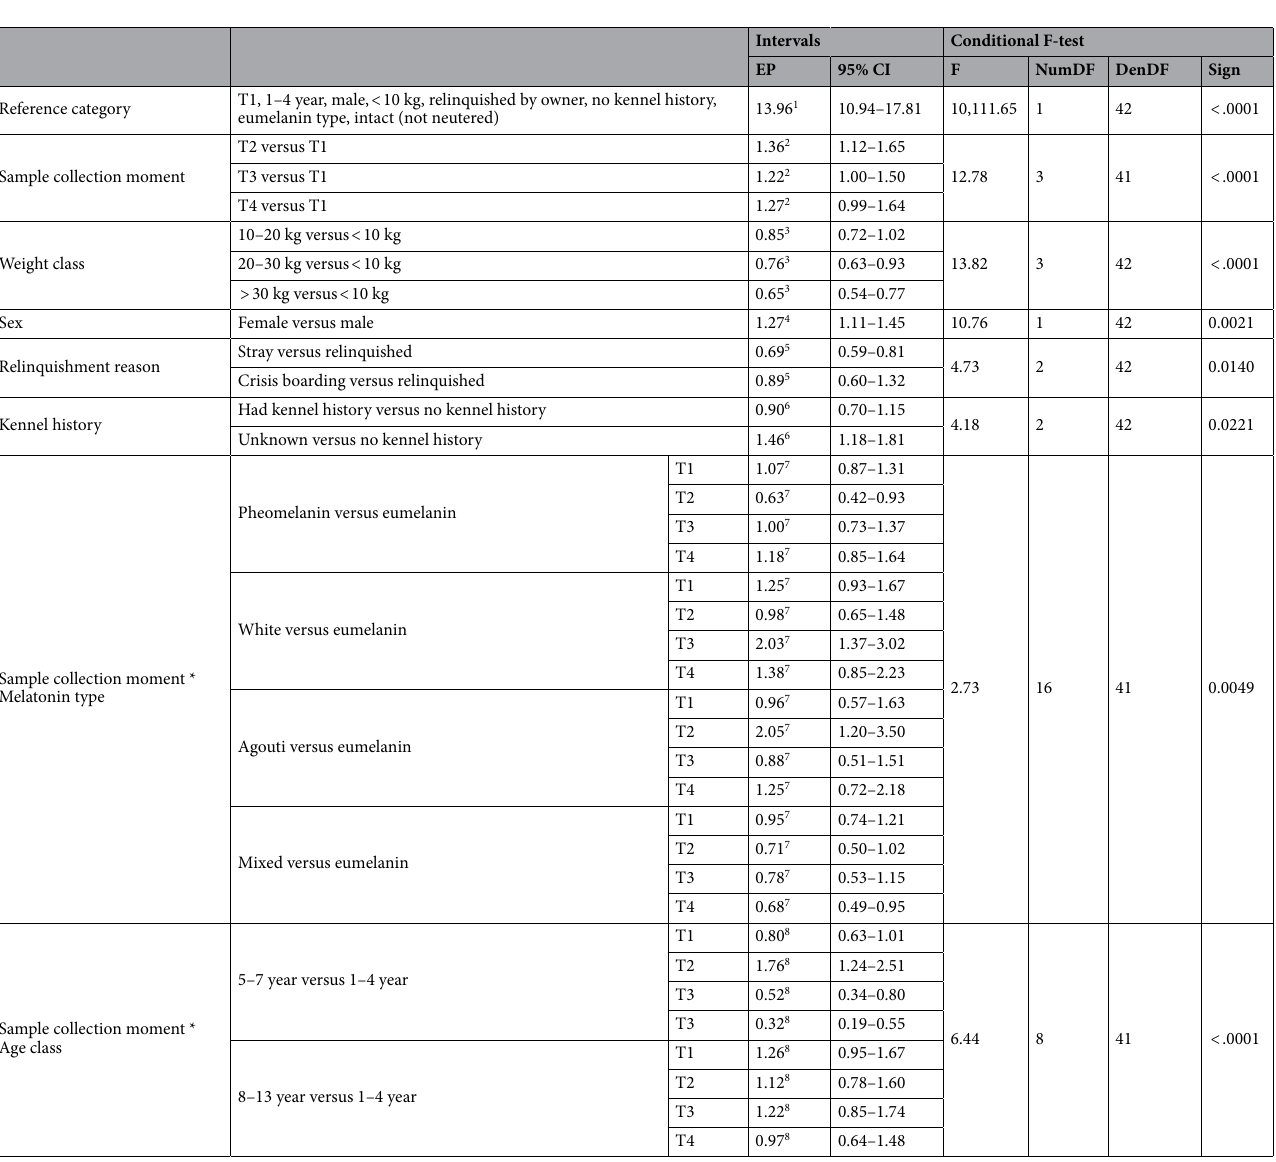
Table 1. Model results of hair cortisol concentration in the shelter dog group. Estimated parameter (EP) and 95% confidence intervals (CI) of HCC at different sampling moments and other factors in the model which significantly explained HCC variability. Conditional F-testing revealed F, DFs and significance of the different terms in the model. 1 Estimated mean in reference age class, sex, weight class, relinquishment reason, kennel history, melatonin type, neuter status and sample collection moment T1. 2 Estimated ratio of mean of specified sample collection moment and mean at T1. 3 Estimated ratio of mean of specified weight class and mean in reference weight class. 4 Estimated ratio of mean of specified sex and mean in reference sex. 5 Estimated ratio of mean of specified relinquishment reason and mean in reference relinquishment reason. 6 Estimated ratio of mean of specified kennel history information and mean in reference kennel history information. 7 Estimated ratio of mean of specified melatonin type and mean in reference melatonin type at same sample collection moment. 8 Estimated ratio of mean of specified age class and mean in reference age class at same sample collection